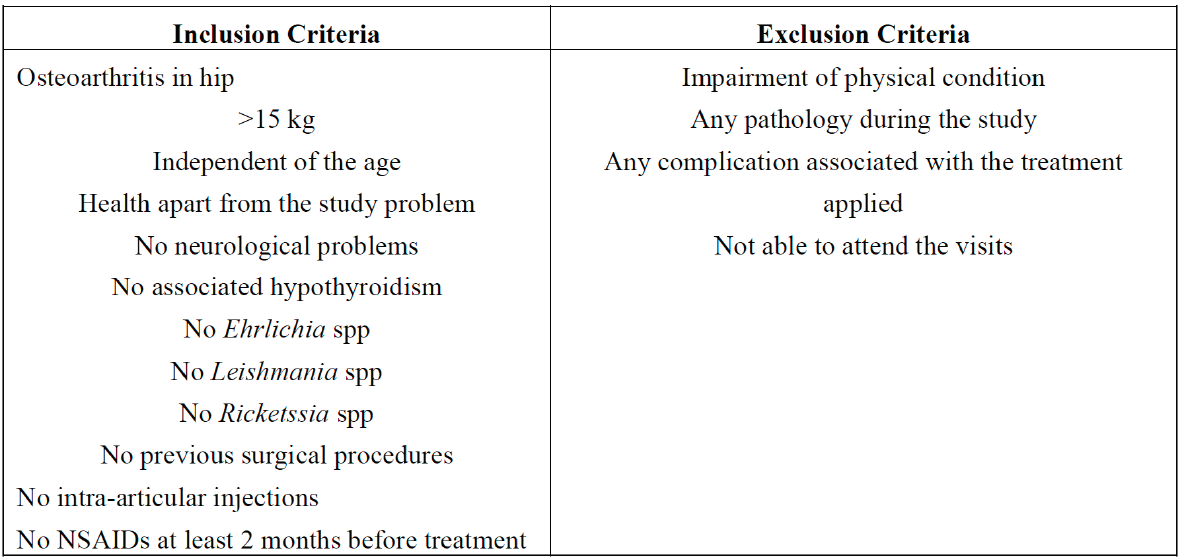
Figure 5. Inclusion and exclusion